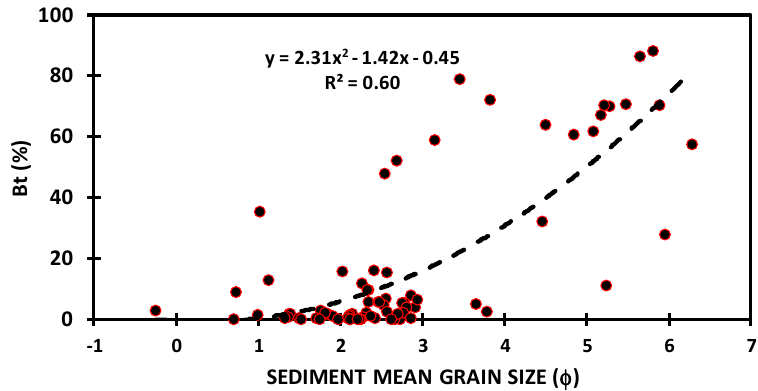
Figure 22. Correlation between biotite frequency and sediment mean grain size using a polynomial function of degree 2.